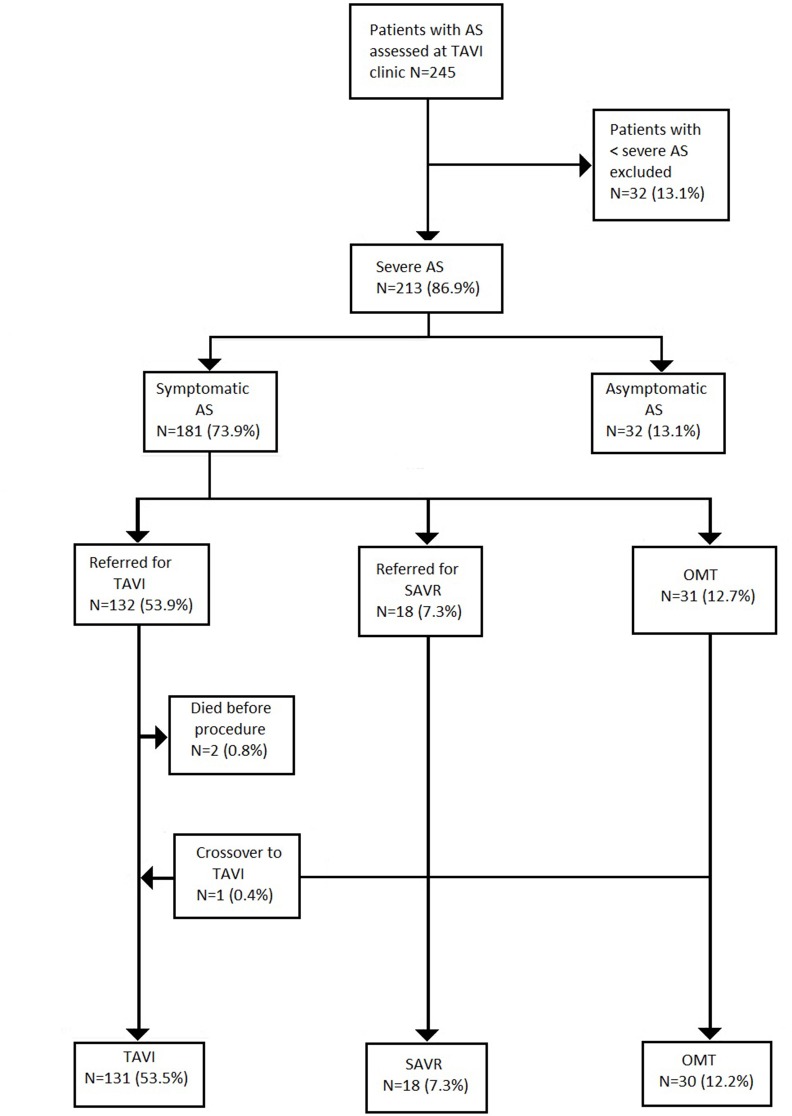
Patients flow. Values are number (%). AS, aortic stenosis; TAVI, transcatheter aortic valve implantation; SAVR, surgical aortic valve replacement; OMT, optimal medical therapy.